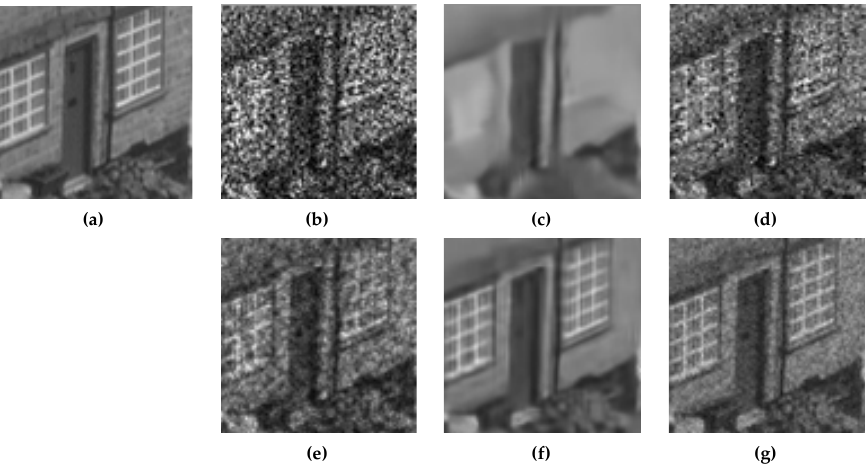
Figure 3. Filtering results of the image “Hill” corrupted by simulated speckle (first scene with unchanging and 1-Look noise): ( a ) Reference image (noise-free); ( b ) Noisy with single-look; ( c ) Fast adaptive nonlocal SAR despeckling (FANS); ( d ) Change detection matrix based filter (CDMF); ( e ) Quegan’s filter (QF); ( f ) Multitemporal SAR block-matching and 3D filtering (MSAR_BM3D); ( g ) Proposed.